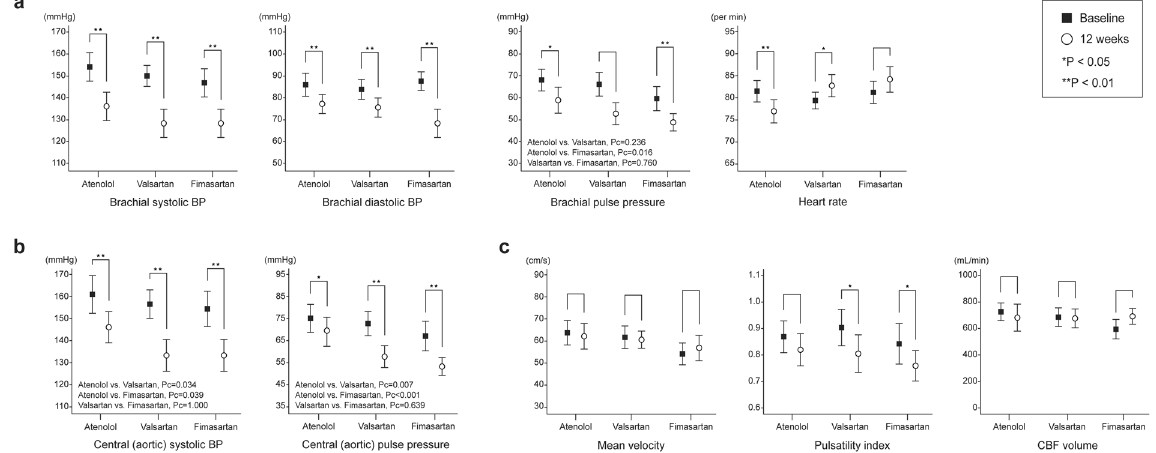
Figure 2. Mean changes in brachial, central pressure and cerebral haemodynamic parameters between baseline and 12 weeks. Regardless of similar brachial blood pressure (BP) reduction ( a ), central systolic BP and central pulse pressure ( b ) showed significant difference in ARB groups. The pulsatility index on transcranial Doppler ( c ) after 12 weeks was significantly reduced in valsartan (p = 0.002) and fimasartan groups (p = 0.008). * p < 0.05, ** p < 0.01.